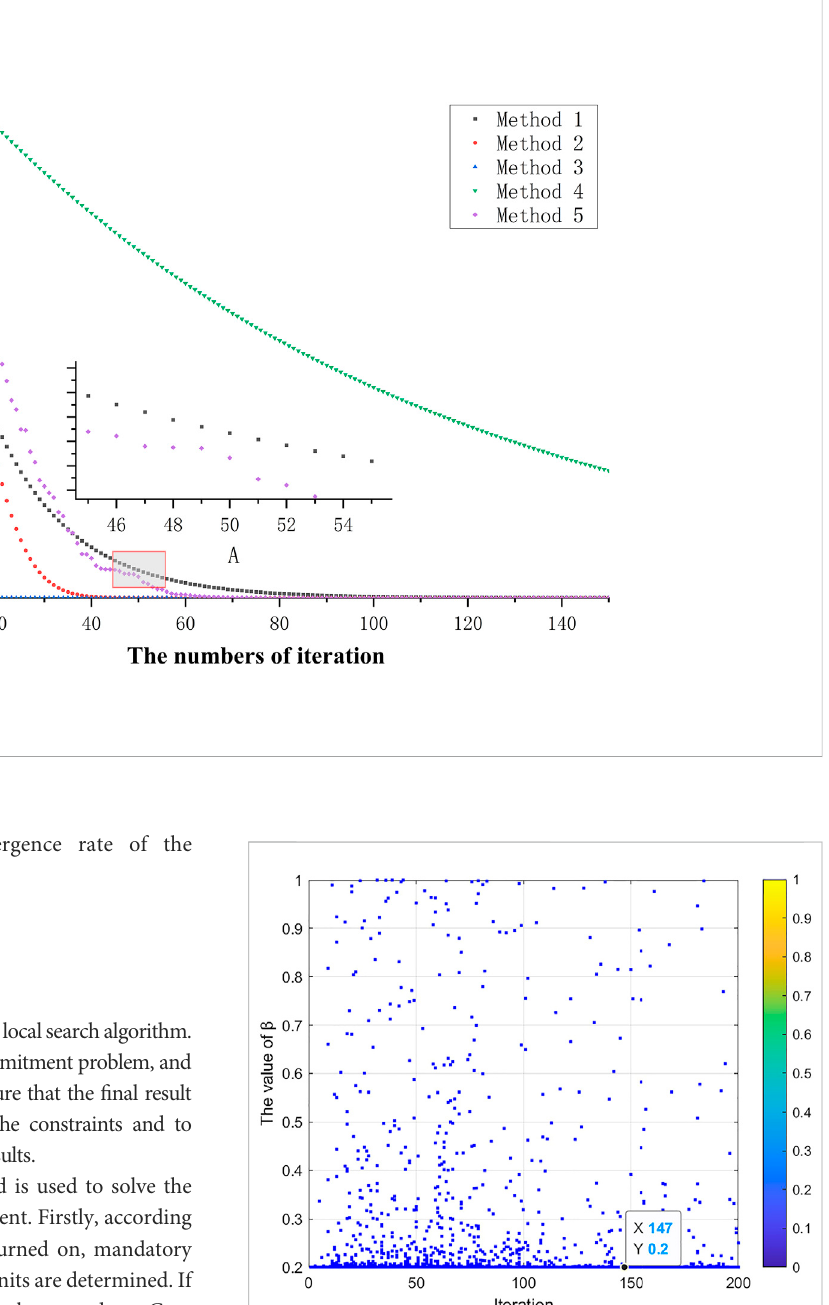
FIGURE 3 The iterated graph of β